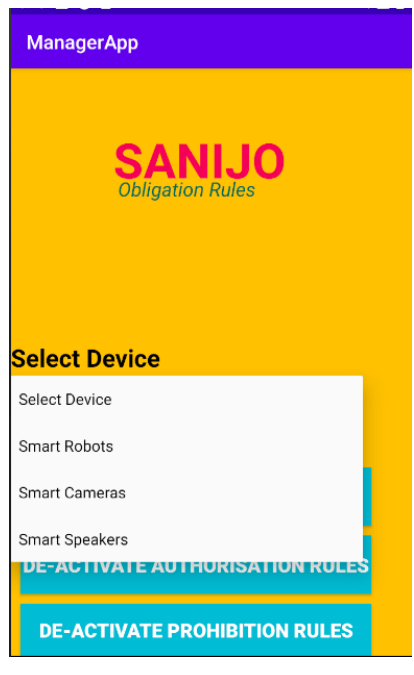
Figure 6. SANIJO Interface: Smart